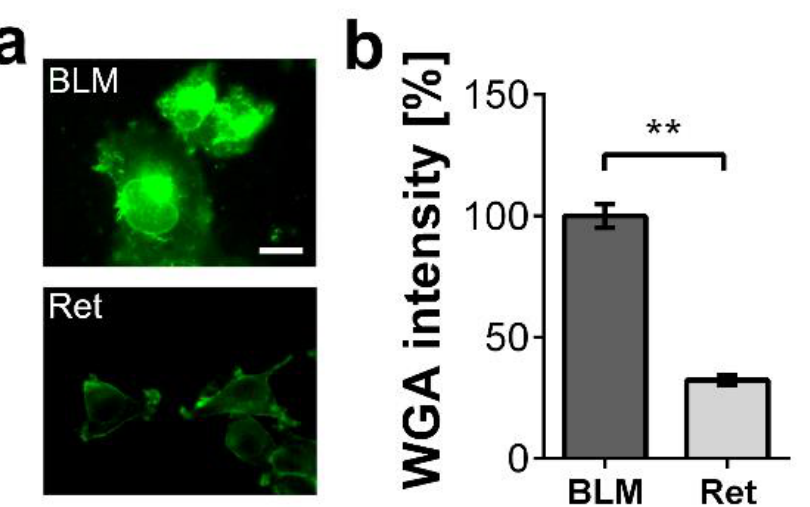
Figure 2. Glycosaminoglycan expression by the melanoma cell lines BLM and Ret. ( a ) Fluorescence microscopy of melanoma cell surfaces labeled with fluorescein isothiocyanate (FITC) conjugated WGA (green). Scale bar = 20 µ m ( b ) Quantitative evaluation of the WGA staining intensity. n = 10 fields of view; ** = p ≤ 0.01 Student’s t -test.